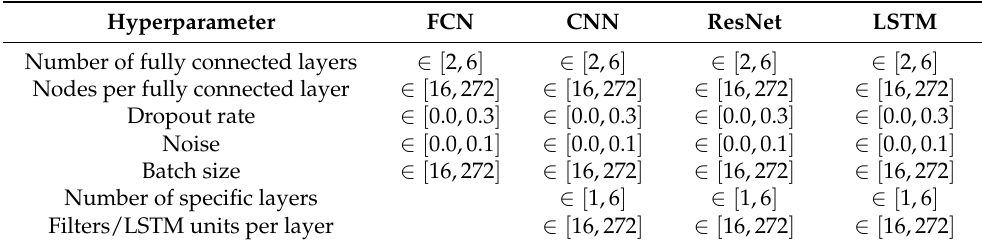
Table 2. Intervals of the search spaces during the hyperparameter tuning for the different deep learning architectures. The number of specific layers corresponds to convolutional layers for the CNN, LSTM layers for the LSTM and ResNet